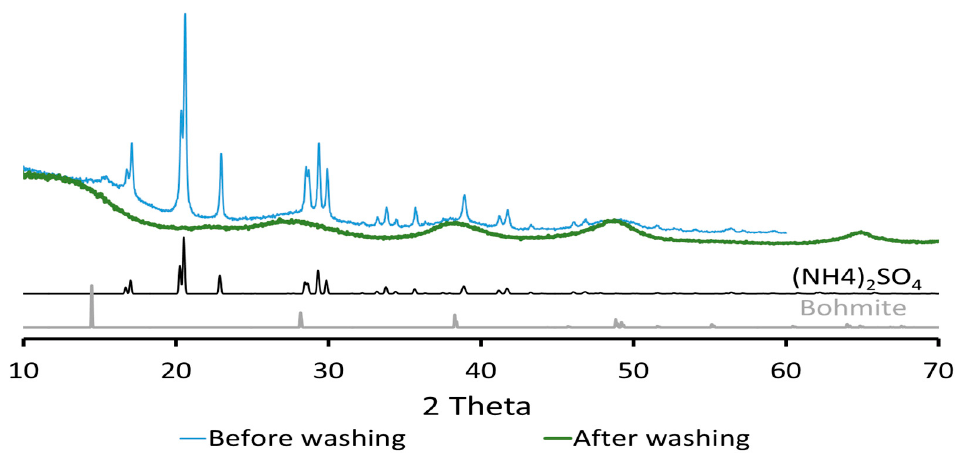
Figure 10. X-ray pattern of the alumina precipitate before and after the